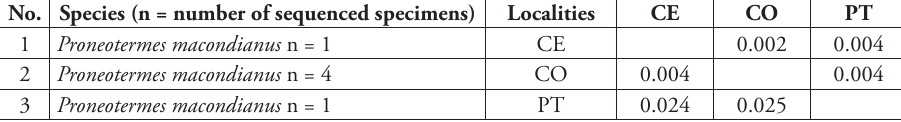
Table 4. Nucleotide distances for combined analysis of COII, 12S rDNA and 16S rDNA genes between localities of P. macondianus sp. n. ( p -distance). Standard error estimates are shown above the diagonal. No. Species (n = number of sequenced specimens)